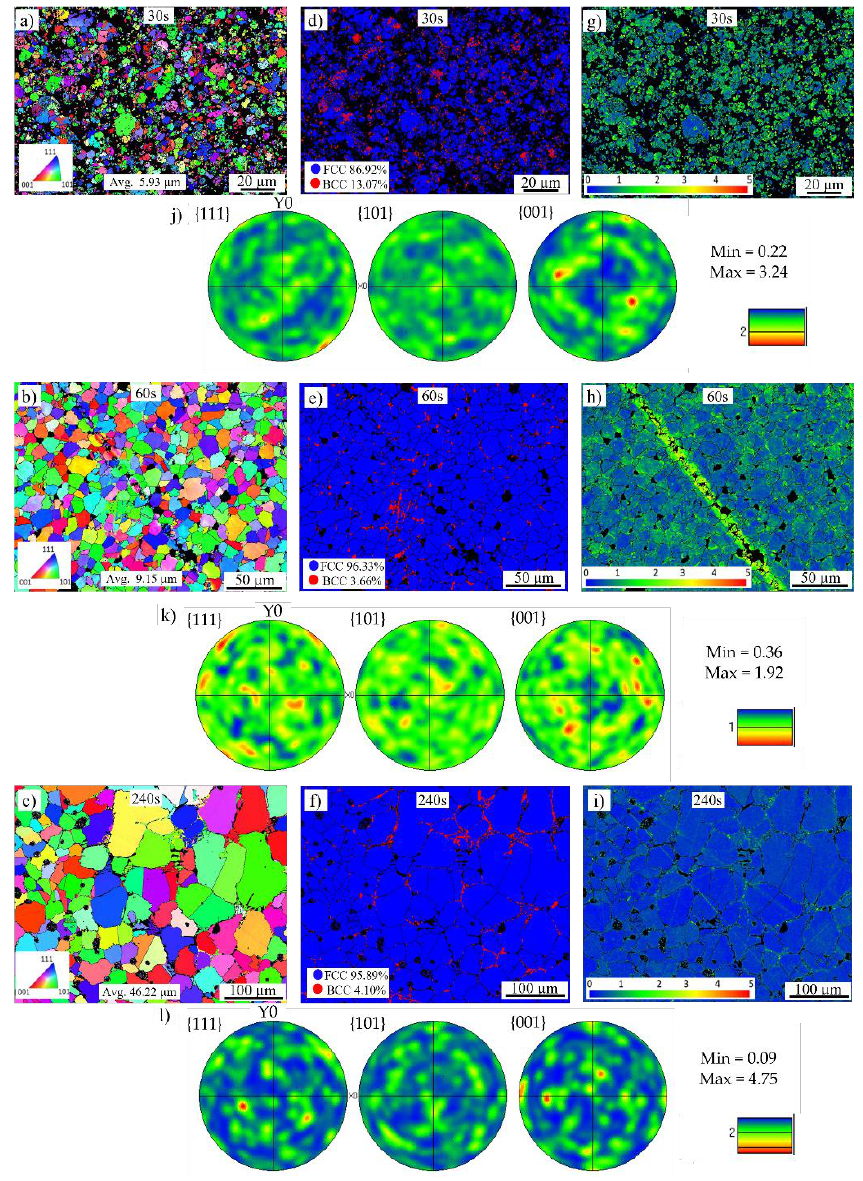
Figure 10. EBSD maps of the refractory ballast sintered specimens after ( a ) 30 s, ( b ) 60 s, ( c ) 240 s, phase maps of the specimens after ( d ) 30 s, ( e ) 60 s, ( f ) 240 s, local misorientation maps after ( g ) 30 s, ( h ) 60 s, ( i ) 240 s and Euler pole figures after ( j ) 30 s, ( k ) 60 s, and ( l ) 240 s.